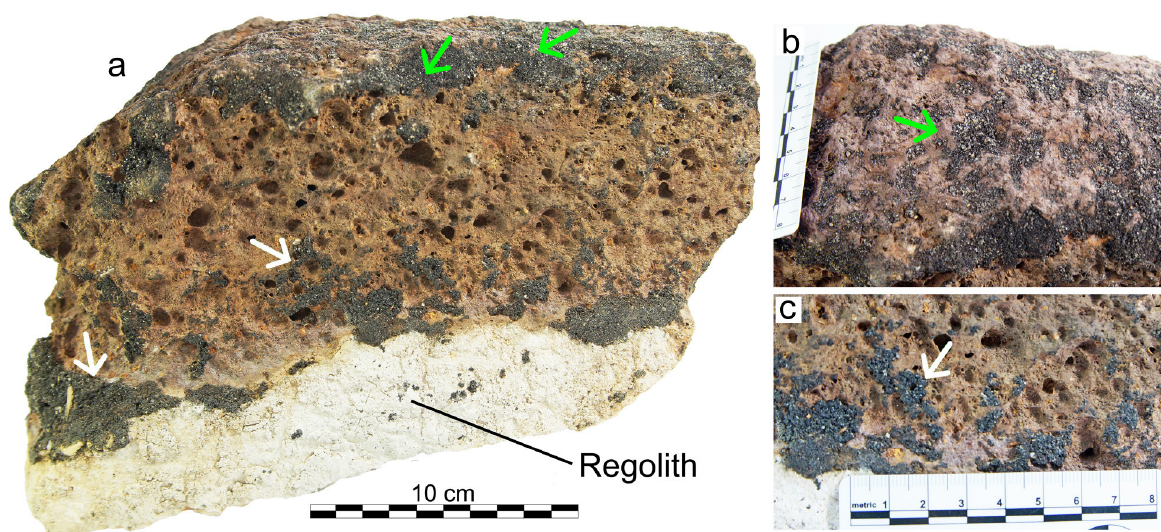
Figure 8. Mesoscopic rock sample collected from the outcrops of the backshore of Itapuama Beach in December 2019. a) Image of a joint face. b) The picture shows that the contaminant encrusted the vesicles in the external surfaces of the outcrops (green arrows - top), ) and percolated through the joints, creating accumulations in their contacts (white arrows). The whitish part of the sample marks the buried zone (bottom) which has been leached and